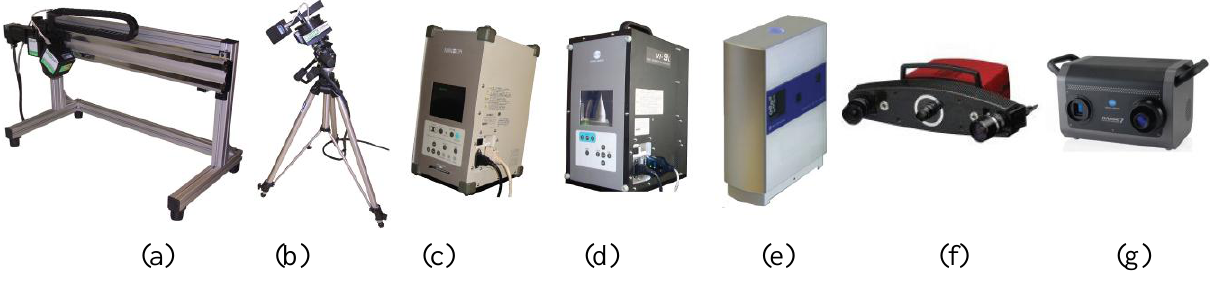
Figure 2. Set of 3D laser scanner technology used in our experiment, from left to right: (a) SG100 (ShapeGrabber Inc.), (b) SG1000 (ShapeGrabber Inc.), (c) Vivid910 (Minolta), (d) V9i (Minolta), (e) NextEngine (NextEngine Inc.), (f) Athos (GOM), ( g)